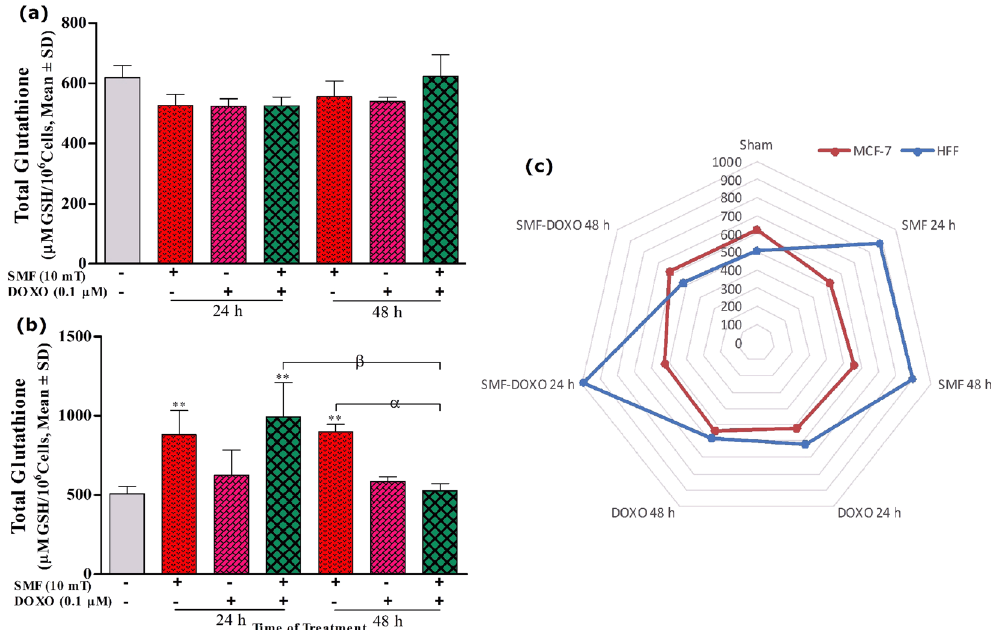
Figure 6. The total intracellular glutathione (tGSH) results of ( a ) MCF-7, ( b ) HFF cells and ( c ) both comparison exposed with 10 mT SMF and incubated with 0.1 μ M DOXO for two exposure times (24 and 48 h). The GSH was measured by a microplate reader, and results are expressed as the concentration of glutathione content ( μ M GSH per 10 6 cells). Data are shown as mean ± SD (n = 3). ** P < 0.01. Significant difference relative to unexposed cells (sham; was measured at 48 h), and letters ( α ,P < 0.05; β ,P < 0.01). Significant differences between treated cells (2 × 2 × 2 factorial ANOVA flowed by post-hoc Newman–Keuls multiple comparison